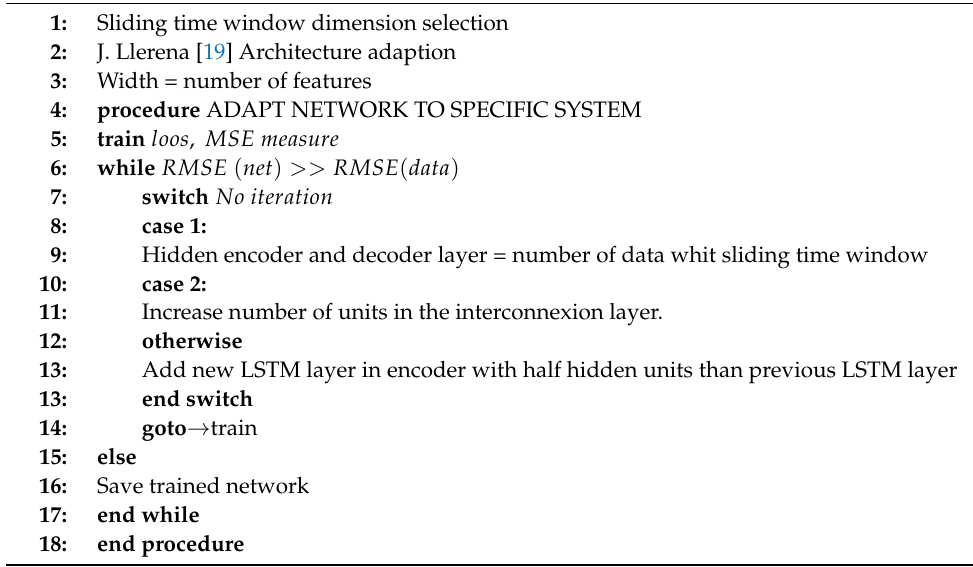
Algorithm 2. The network architecture configuration